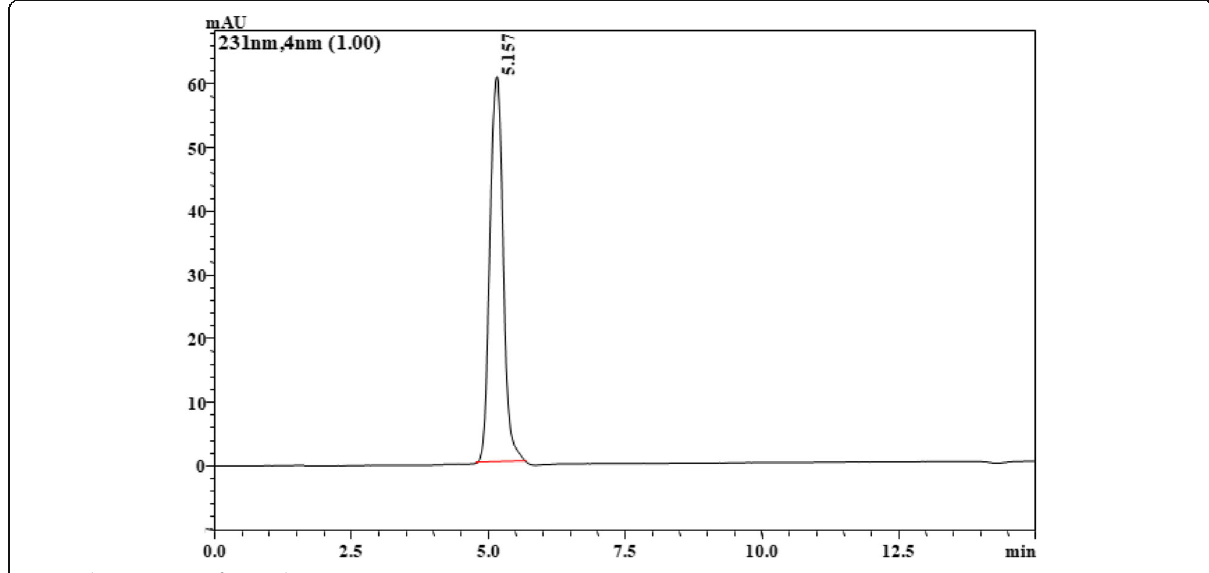
Fig. 4 Chromatogram of